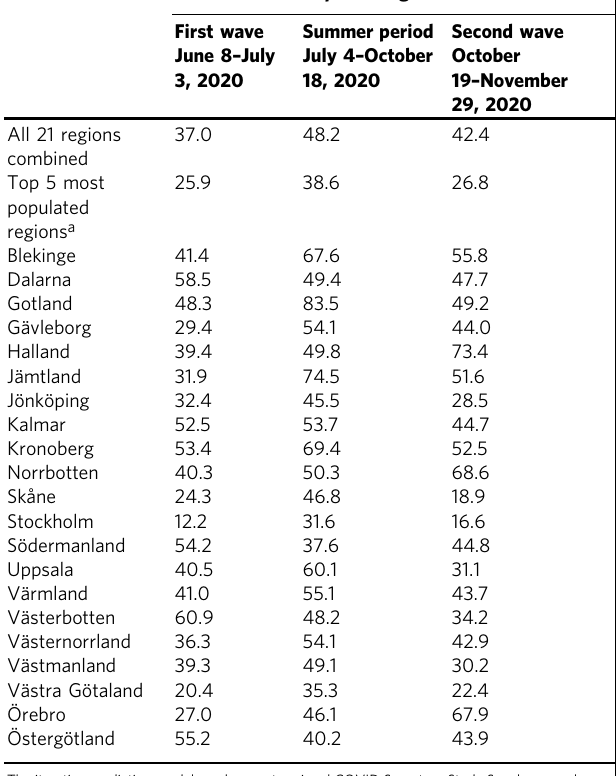
Table 1 Median absolute percentage errors (MdAPEs) for prediction of new daily hospitalizations, across the fi